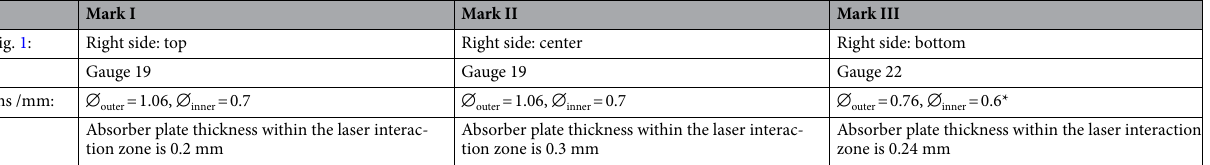
Type: Mark I Mark II Mark III Position Fig. 1: Right side: top Right side: center Right side: bottom Size 22 : Gauge 19 Gauge 19 Gauge 22 Dimensions /mm: ∅ outer = 1.06, ∅ inner = 0.7 ∅ outer = 1.06, ∅ inner = 0.7 ∅ outer = 0.76, ∅ inner = 0.6* Remarks: Absorber plate thickness within the laser interac- tion zone is 0.2 mm Absorber plate thickness within the laser interac- tion zone is 0.3 mm Absorber plate thickness within the laser interaction zone is 0.24 Table 1. Data and remarks about the LaserVit-tips (Mark I-III) used for vitreous body removal. *Customized.